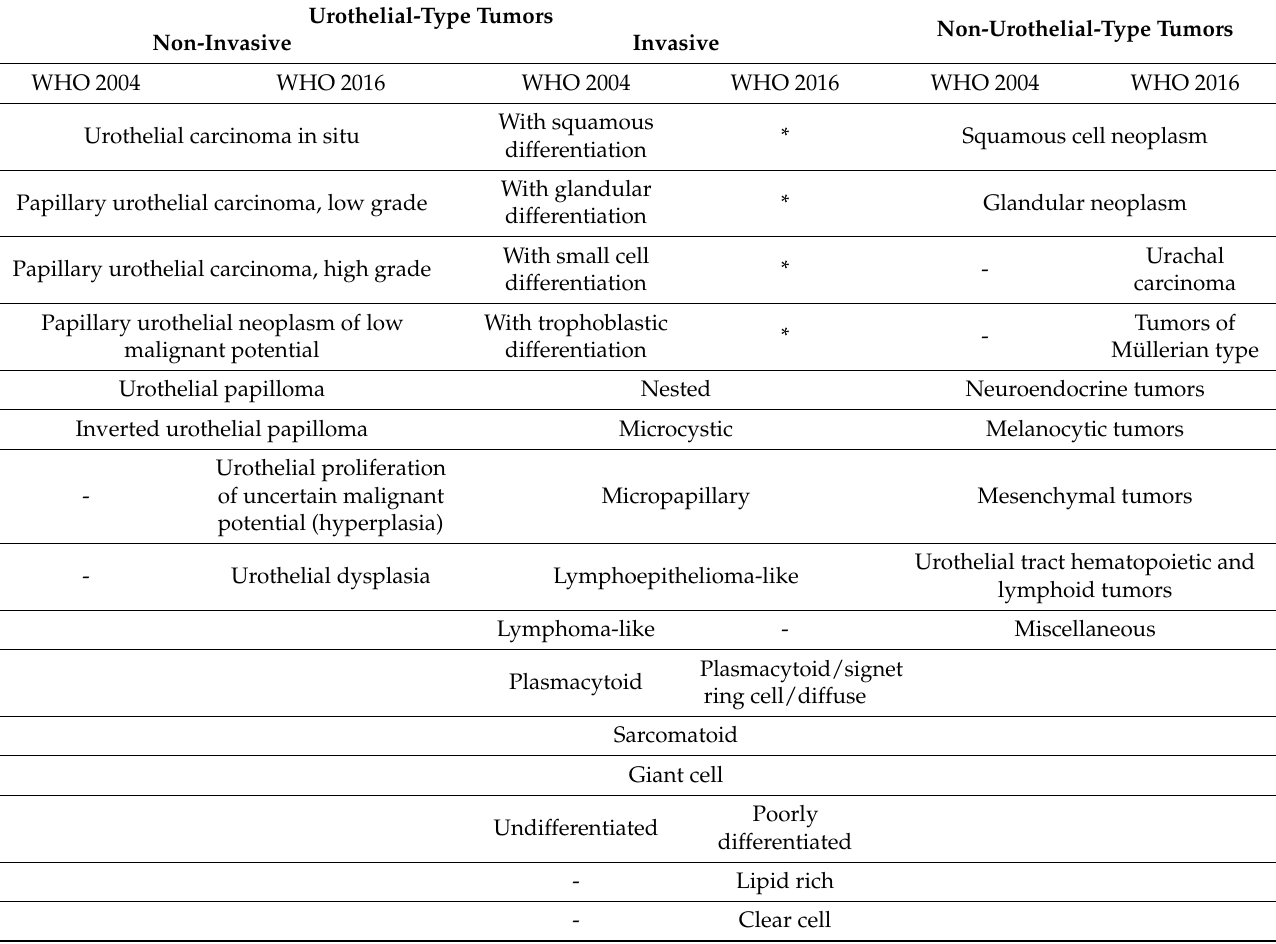
Table 2. Comparison between the third (2004) and the recent fourth (2016) WHO classifications of tumors of the urothelial tract. *, still used informally; -, not present in the corresponding